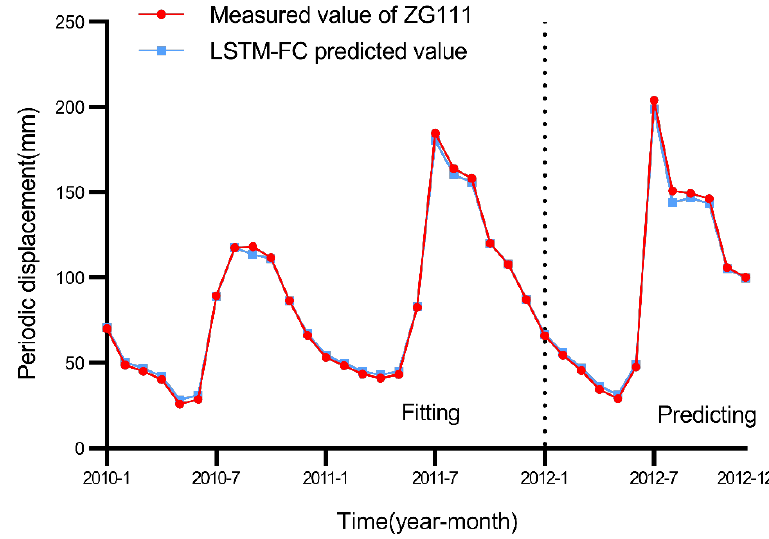
Figure 14. Fitting and predicting results of periodic displacement of ZG111.